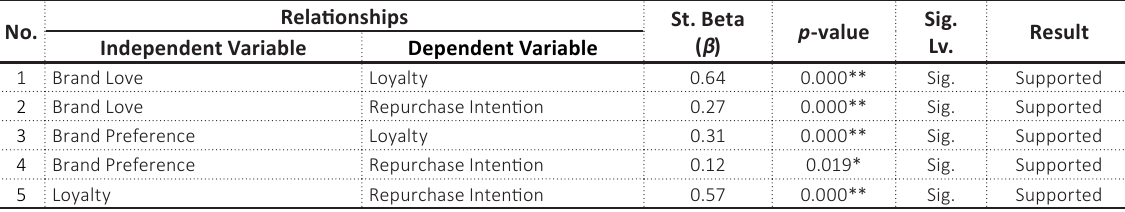
Table 4. Findings and hypotheses testing